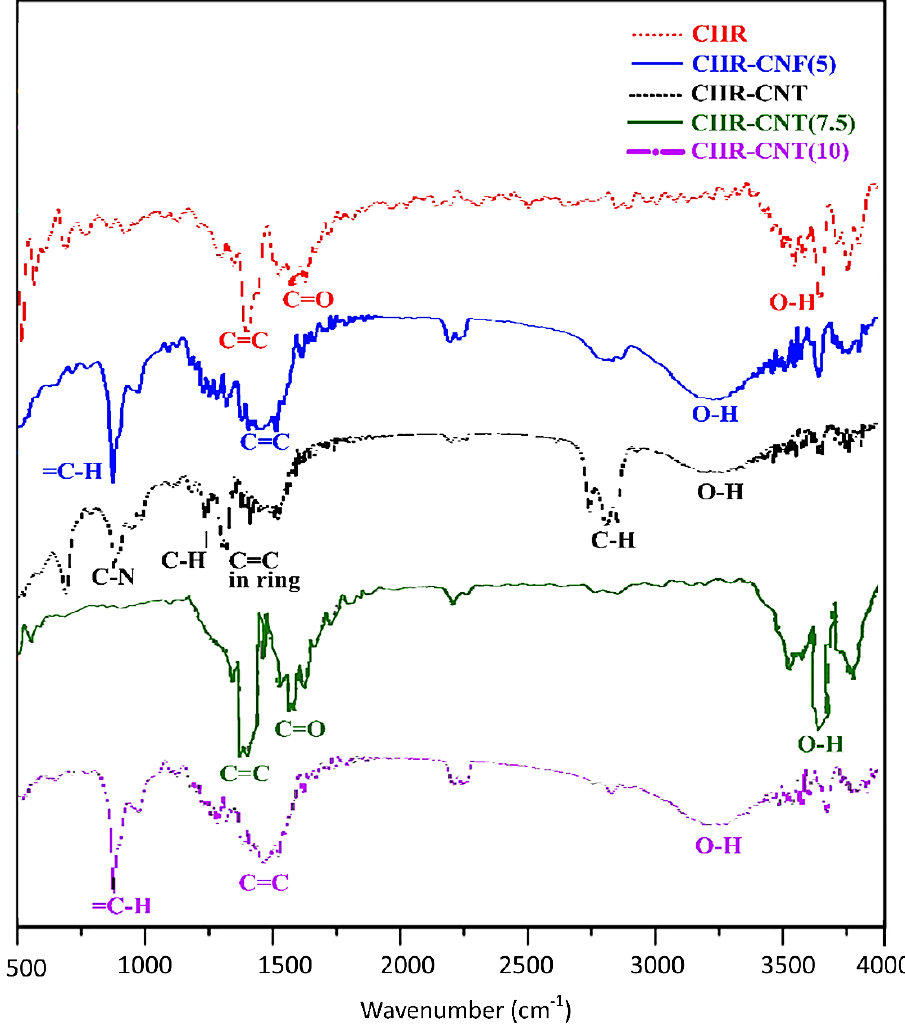
Figure 4. FTIR spectra of CIIR with different fillers CNT/CNF in different